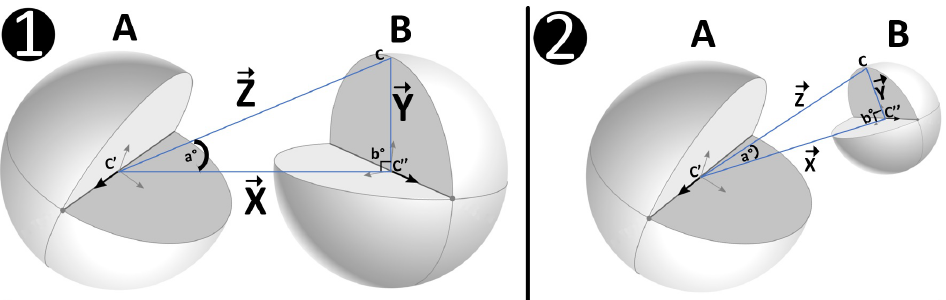
Figure 13. Relationships between nodes in a KG; showing a collection of vectors in n-dimensional Euclidean space. The spheres represent the nodes, and the vectors are letters formed from the relationships between them. 3D rendering explains the vector projection performed by the